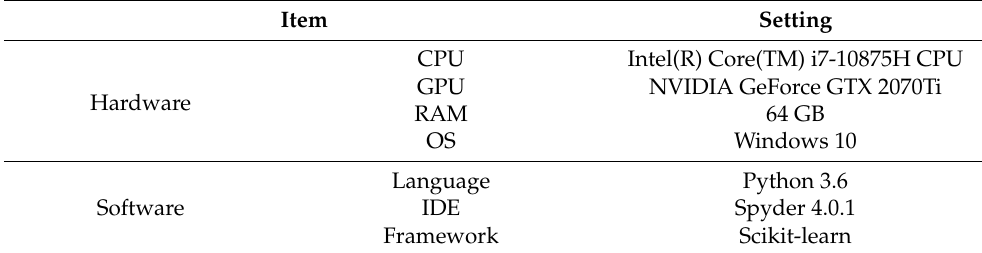
Table 2. Experimental environment settings. Item